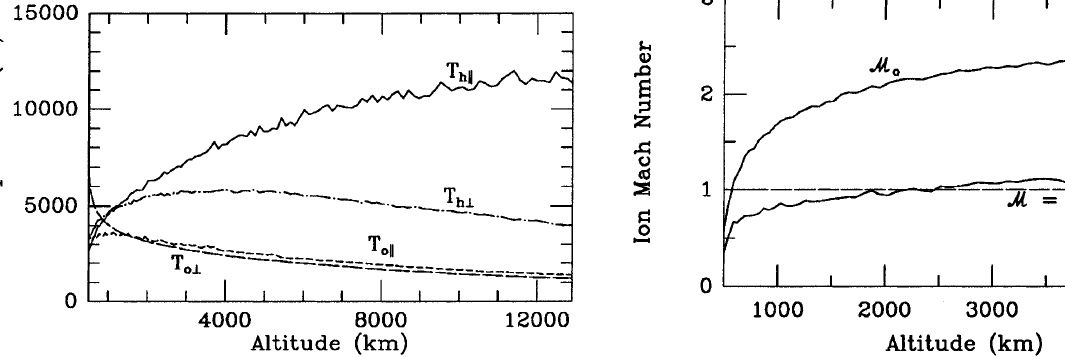
Fig. 4. Profiles of calculated ion temperatures Fig. 5. Ion